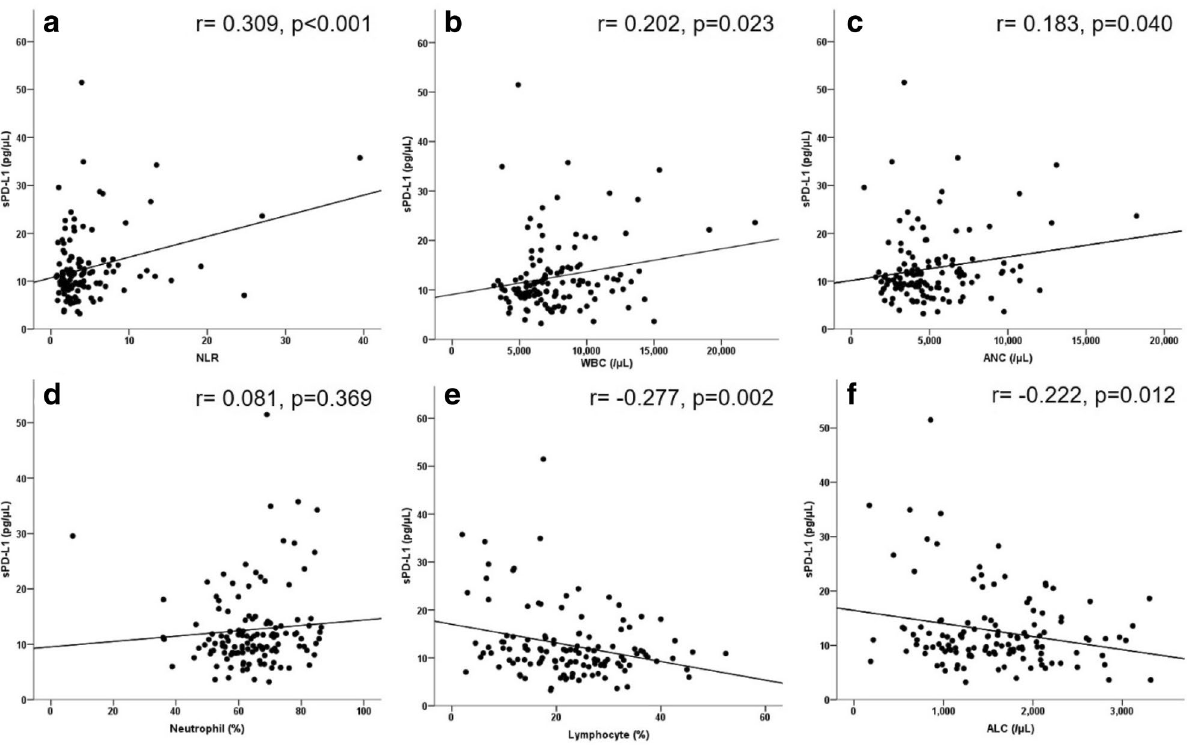
Figure 4. Correlation between sPD-L1 levels and circulating immune cells, including NLR ( a ), WBCs ( b ), ANCs ( c ), neutrophils ( d ), lymphocytes ( e ), and ALCs ( f ). Pearson’s correlation coefficients are denoted as